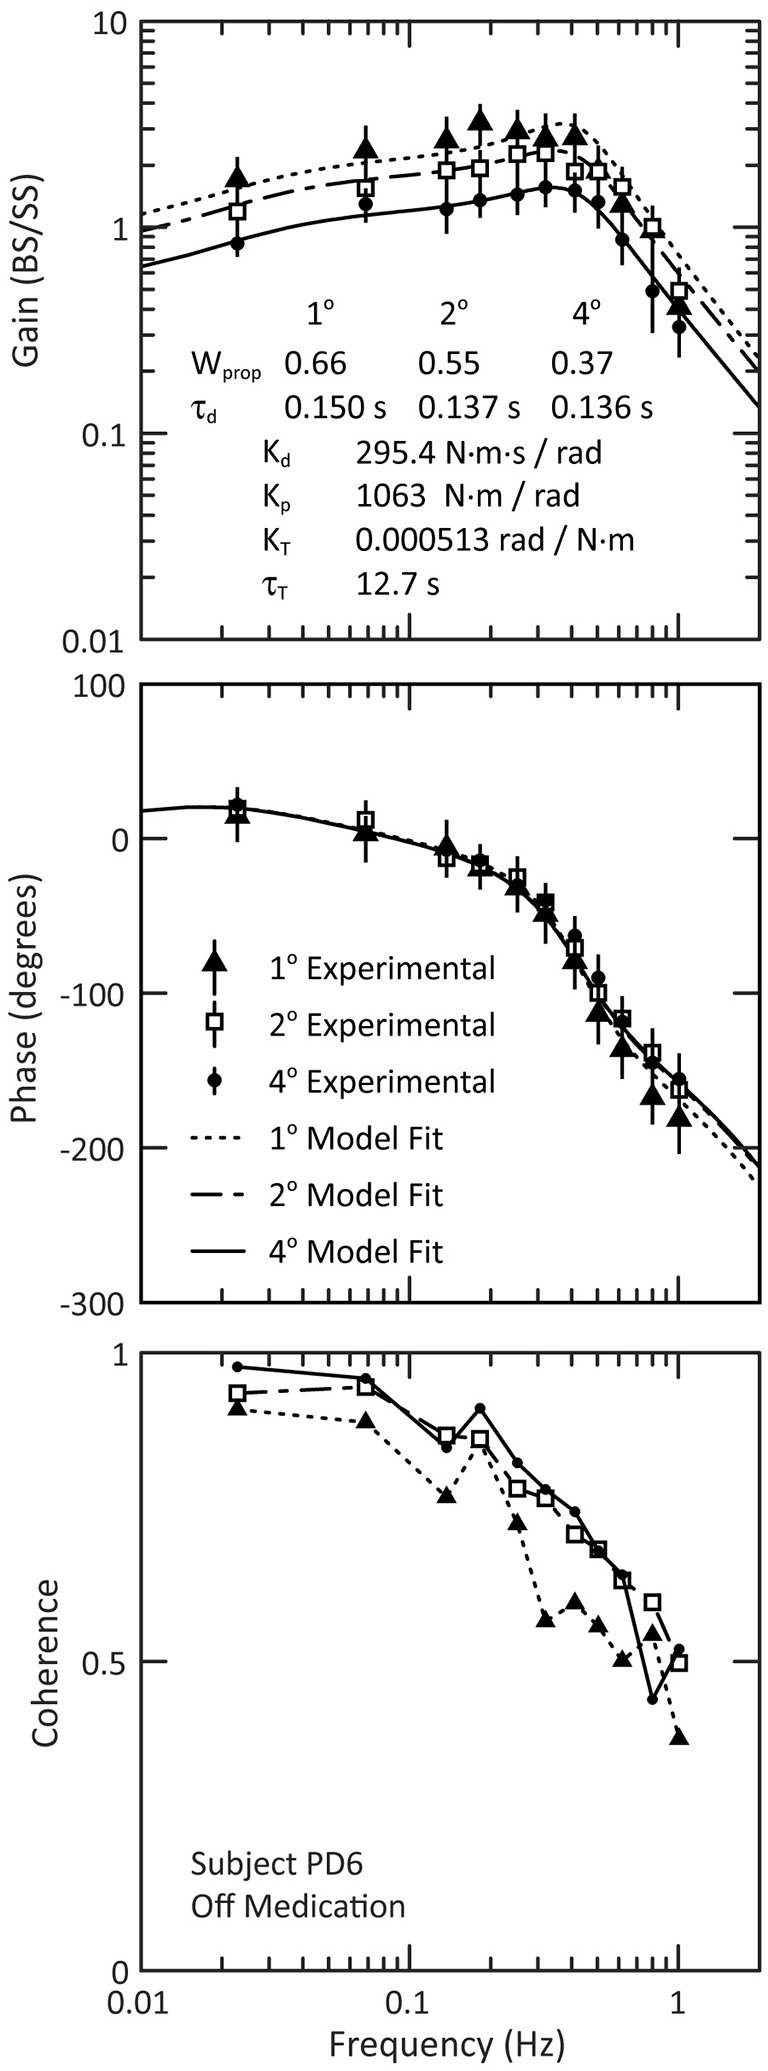
Example of experimental frequency response functions and model fits for PD subject PD6 off medication. The experimental data are shown for the gain (top figure) and phase (middle figure), and the 95% confidence intervals of the mean are indicated by the vertical lines through each data point of the gain and phase curves. The bottom figure shows the coherence of the experimental data. Note that the lines in the coherence plot (bottom figure) are for visualization of the experimental data; these lines are not related to the model fits.